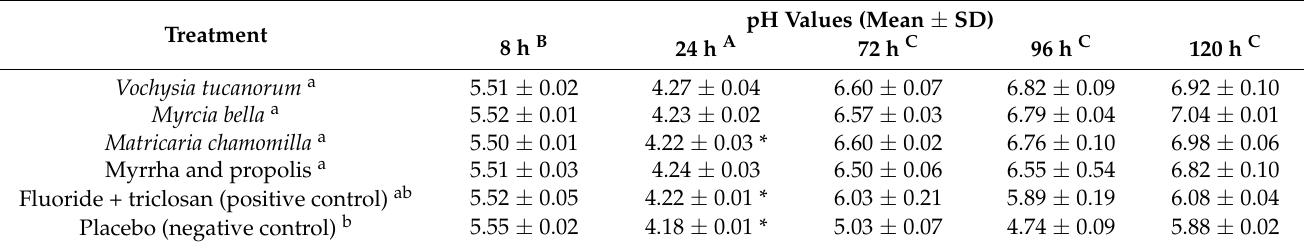
Table 2. The medium pH values during the microcosm biofilm